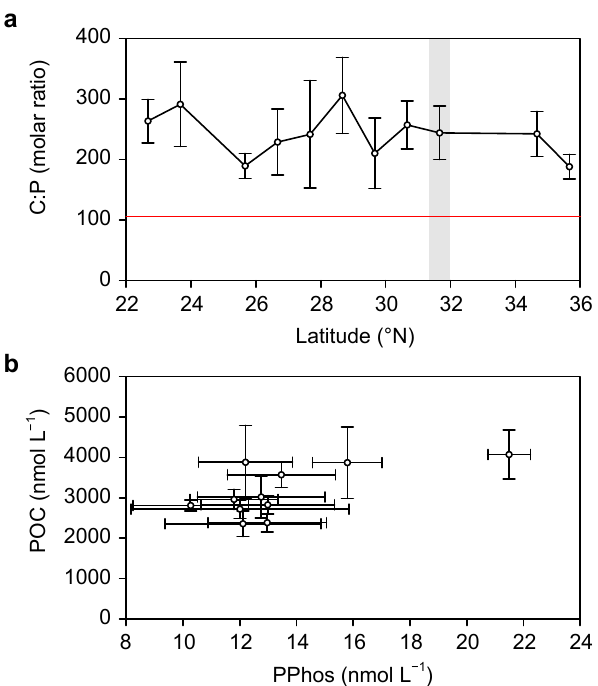
Fig. 4. Relationships between POC and PPhos among sampling sta- tions. (a) C:P molar ratio (geometric means ± SE) as a function of latitude across the BV47 transect (see Fig. 1). Shaded region repre- sents approximate location of BATS. C:P ratios were greater than Redfield (C:P=106, red line) at all stations (P<0.001, Wilcoxon signed rank test). (b) POC as a function of PPhos (Spearman rank correlation, ρ =0.56, P=0.038). Points represent means ± SE.